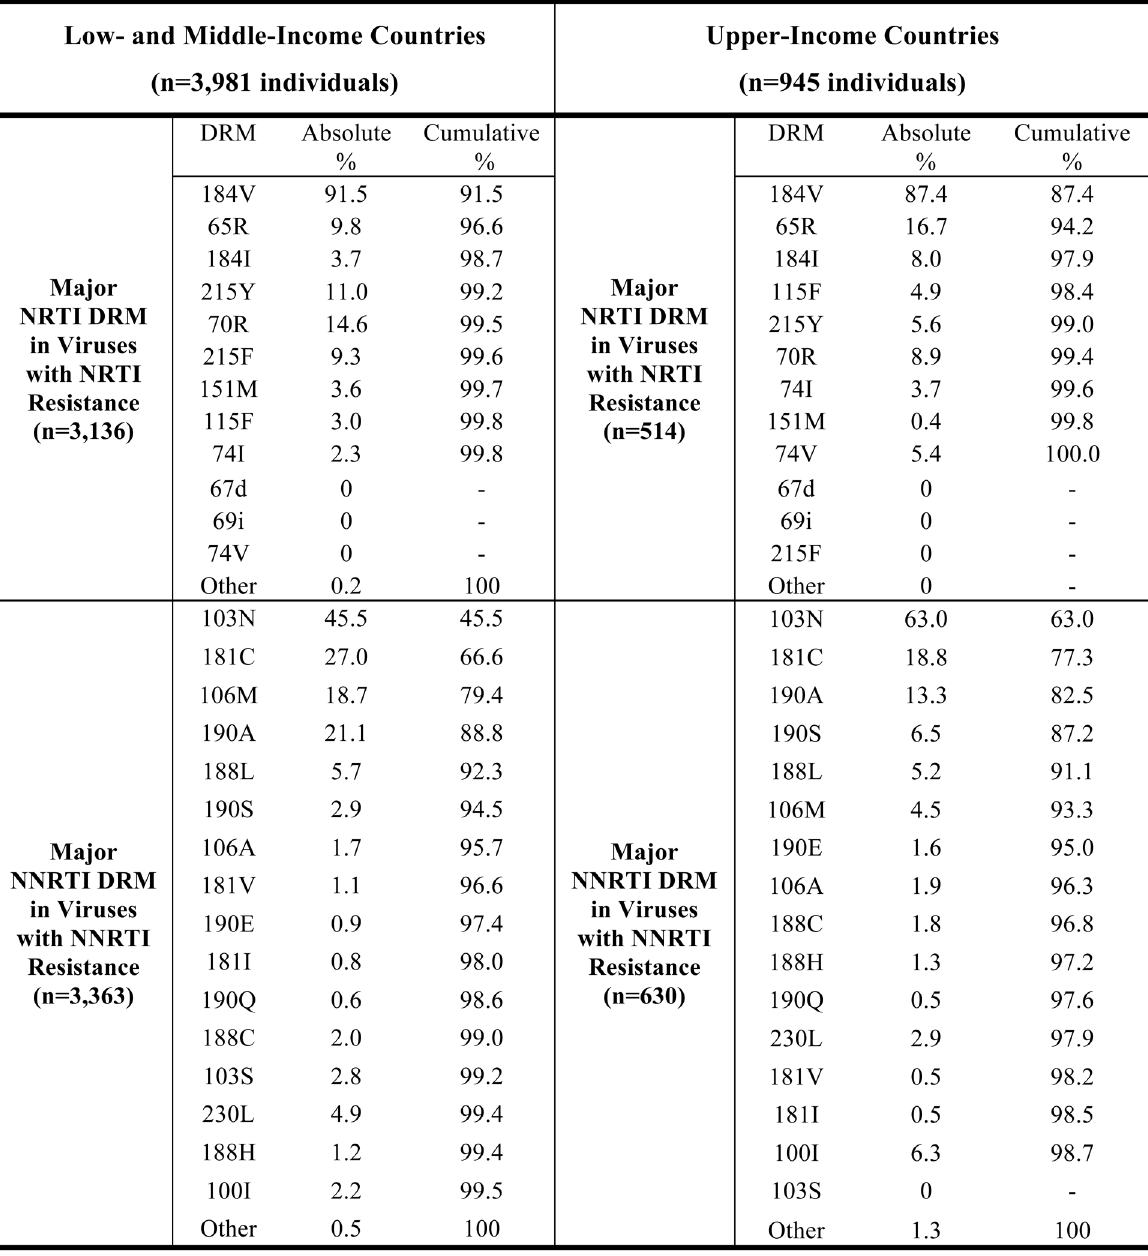
PLOS ONE | DOI:10.1371/journal.pone.0145772 December 30,